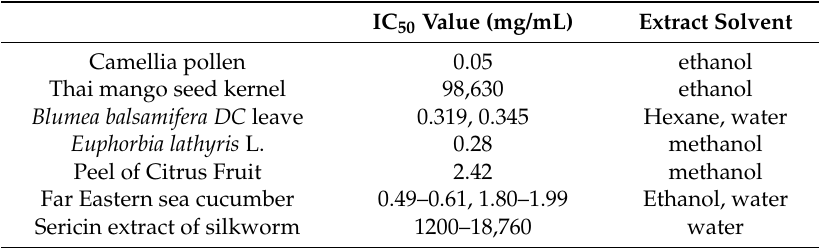
Table 1. Tyrosinase inhibitory activity of natural extracts